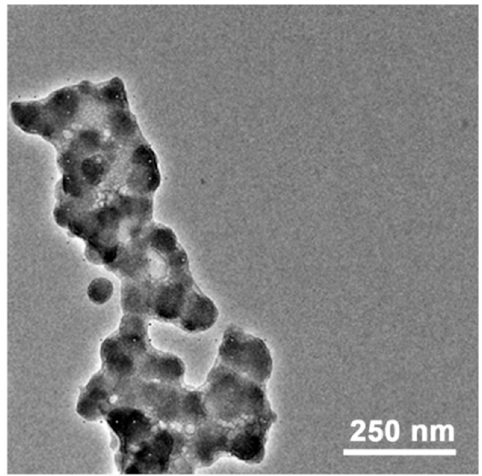
Figure 3 . The morphology of QICY after interaction with RNA in ultrapure water as visualized by TEM.